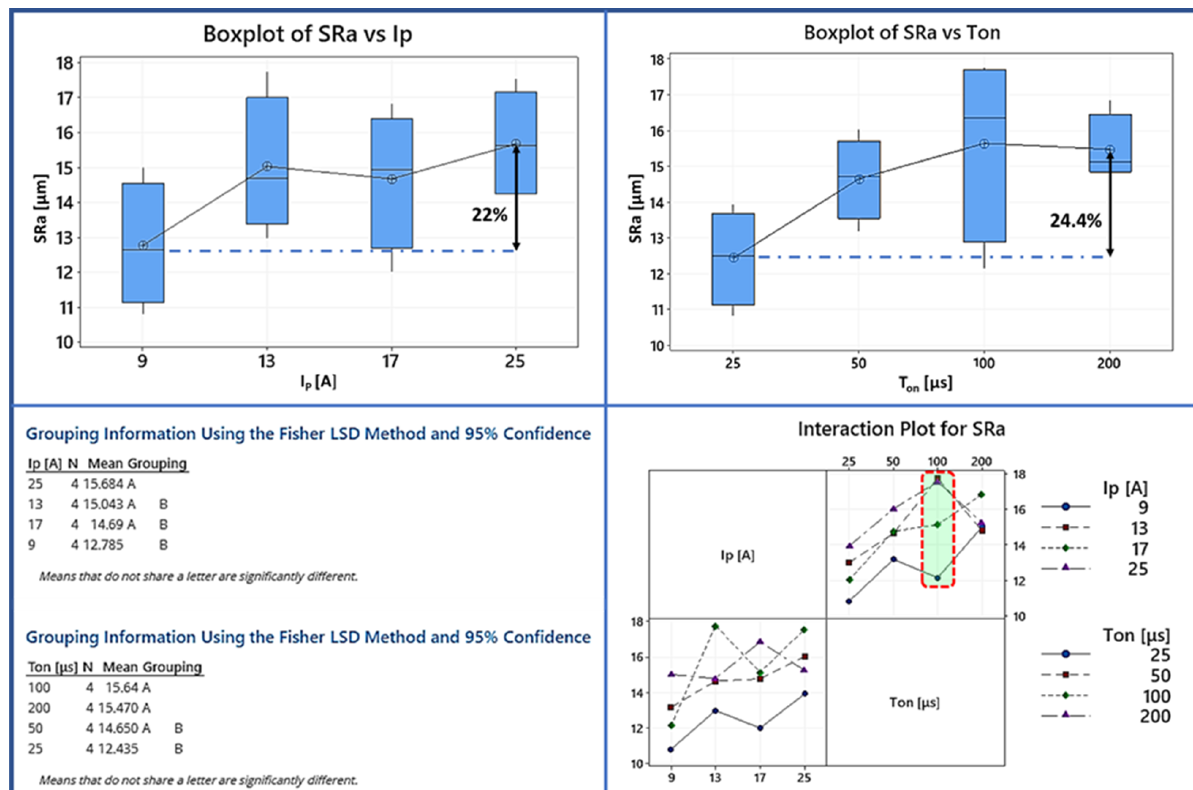
Figure 8. Box plots, Fisher test and interaction plot for the